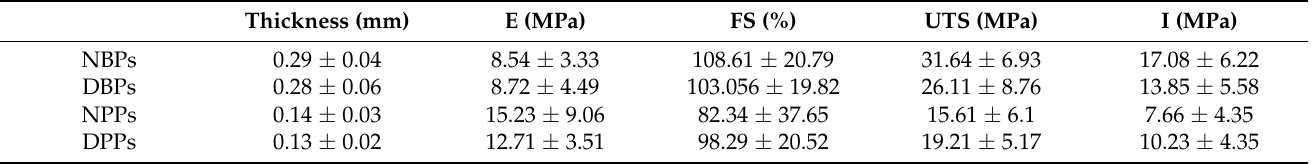
Table 3. Biomechanical properties of the native and decellularized biological tissues 1 .